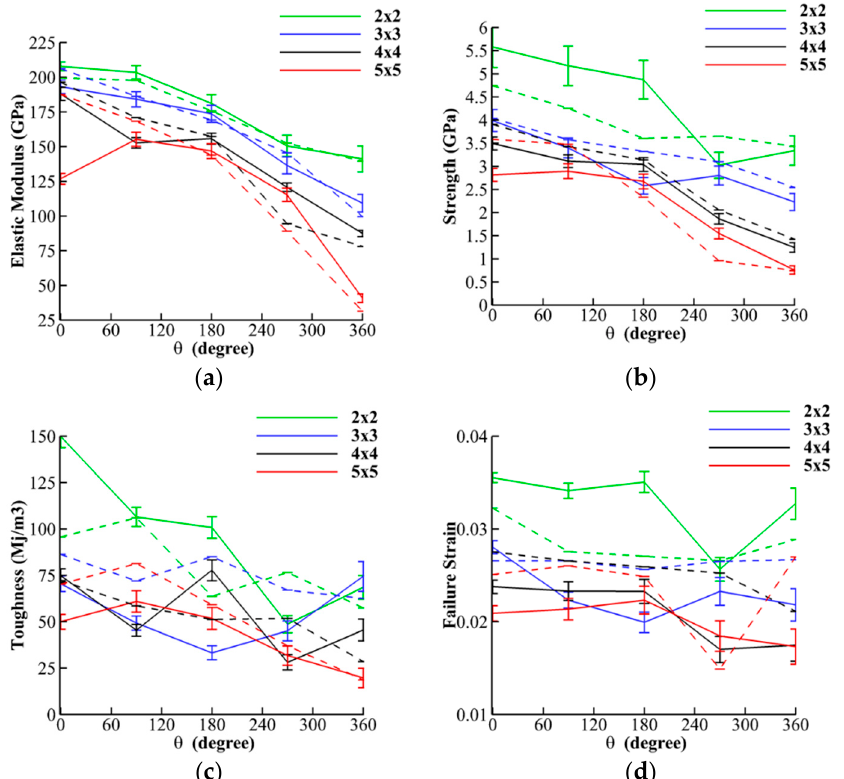
Figure 7. Mechanical performance of twisted bundle of CNCs for different bundle size shown for 𝜖 = 5.0 kcal/mol and 𝜖 = 1.25 kcal/mol with solid and dashed lines, respectively. ( a ) elastic Modulus, ( b ) strength, ( c ) toughness, and ( d ) failure strain.